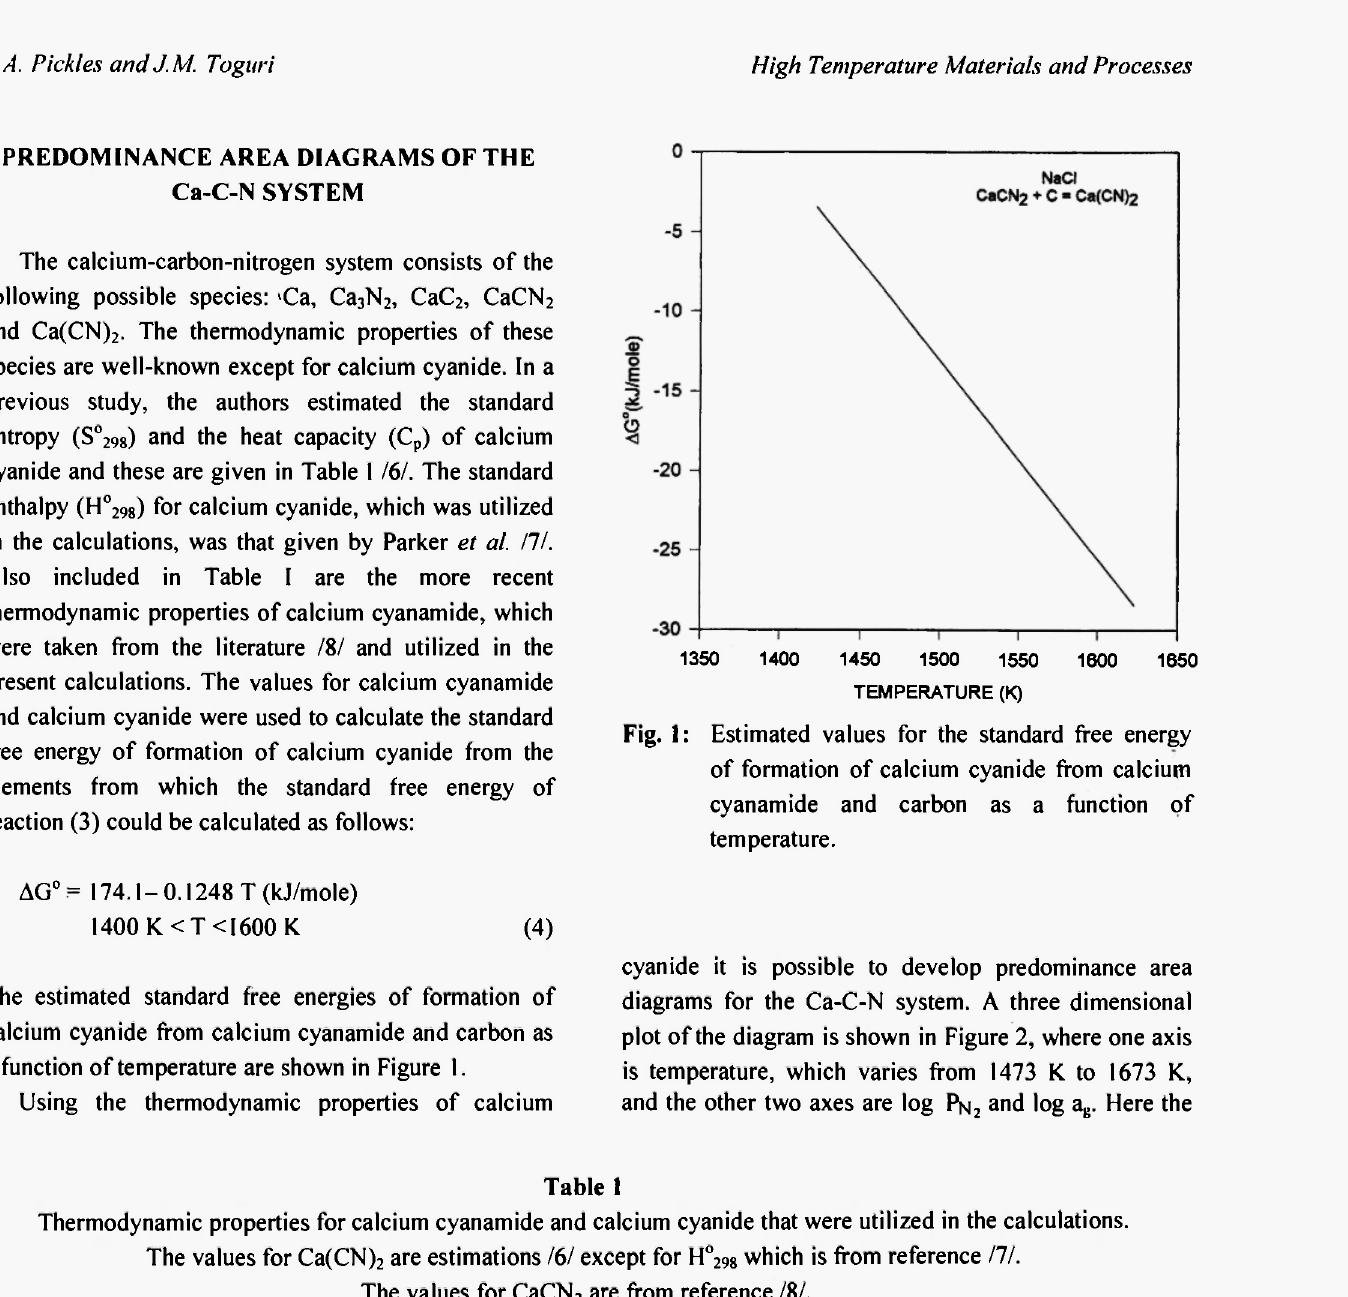
Thermodynamic properties for calcium cyanamide and calcium cyanide that were utilized in the calculations. The values for Ca(CN) 2 are estimations 161 except for H° 298 which is from reference 111. The values for CaCN 2 are from reference /8/.